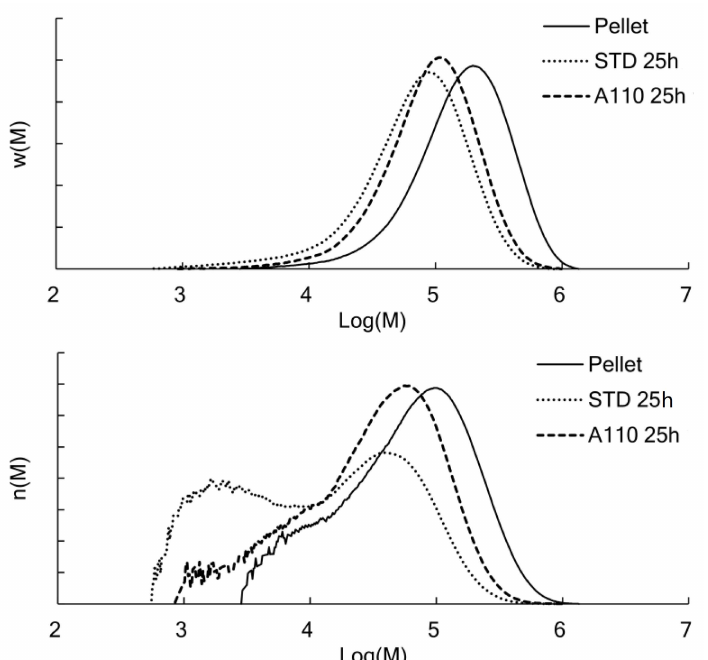
Figure 9. GPC curves with vertical axes of weight fraction (w(M)) and molar fraction (n(W)). Comparison of the raw pellet and the amorphous and annealed specimens hydrolyzed for 25